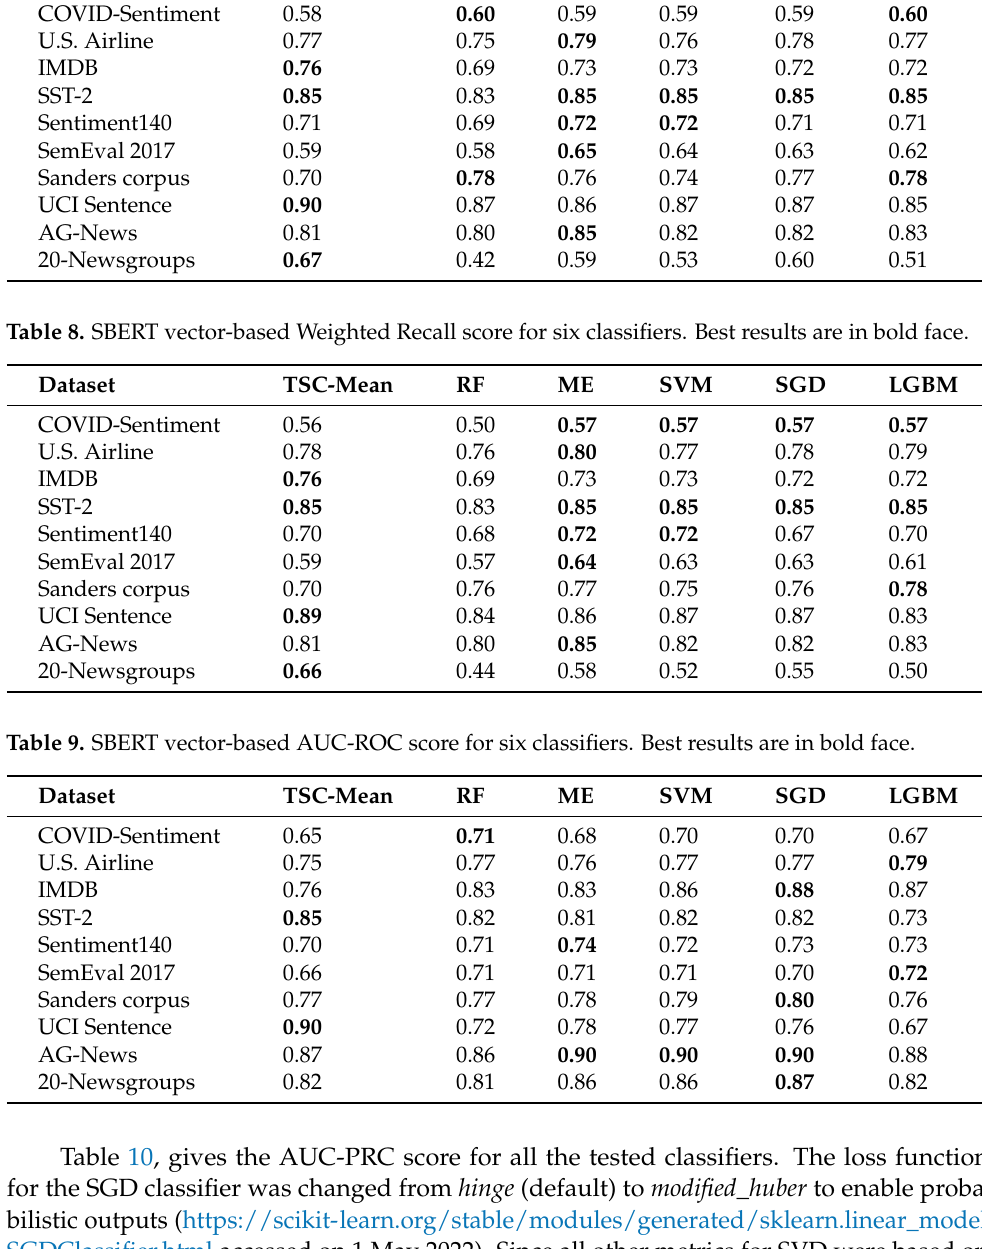
Table 7. SBERT vector-based Weighted Precision score for six classifiers. Best results are in bold face. Dataset